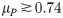
Steady-state diagram and corresponding eigenvalues of the fisheries model as a function of predator death rate μP.(a-c) steady states showing a S-bend shape for J and P variables with color-coded lower (blue), middle (green) and upper (red) branches. Population A shows a linear trend with μp. (d, e) Real and imaginary parts of linearized model. Saddle-node bifurcation points are marked B1 and B2 and indicated by vertical dashed grey lines. Model parameters are c = 1, b = 1, μJ = 0.05, μA = 0.1. Eigenvalues are not relevant for μP ≳ 0.74 since predator population goes negative.